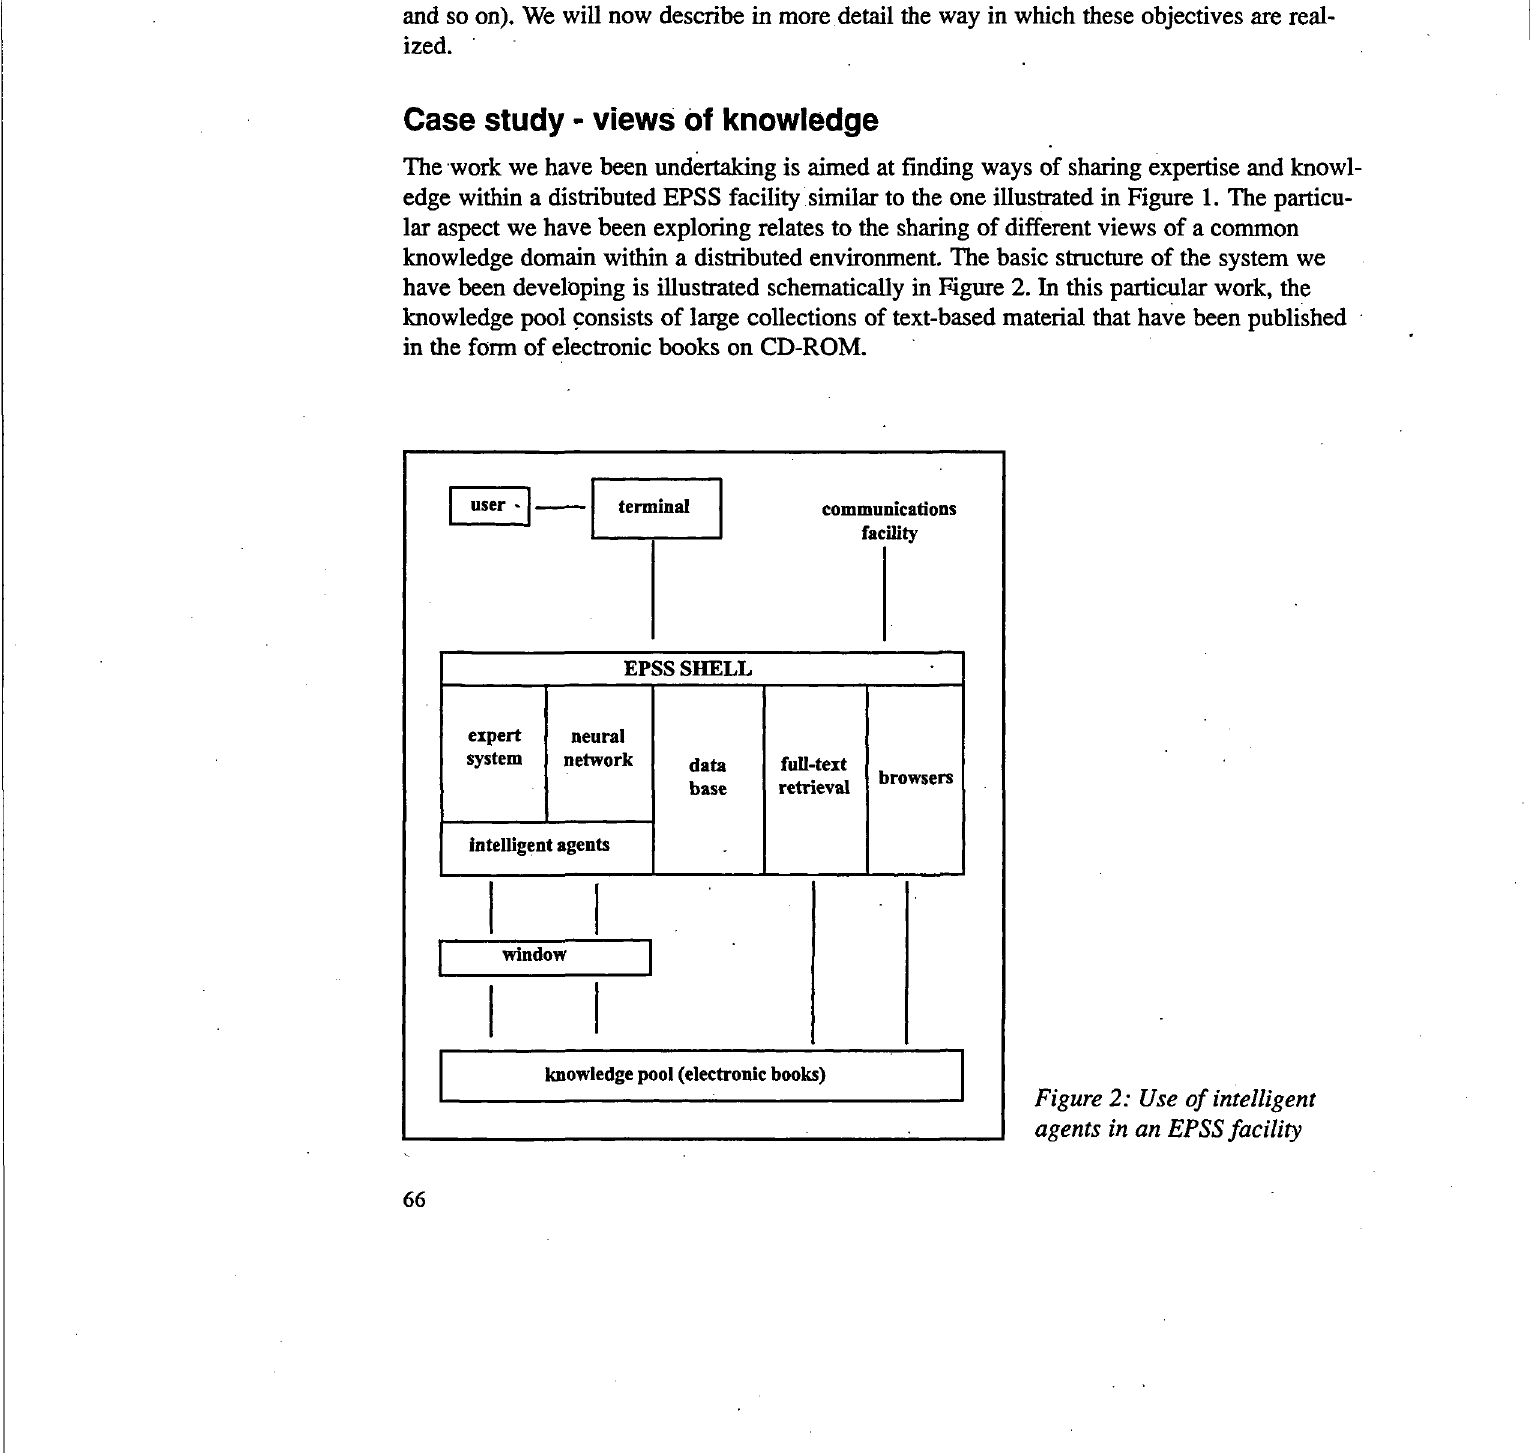
Figure 2: Use of